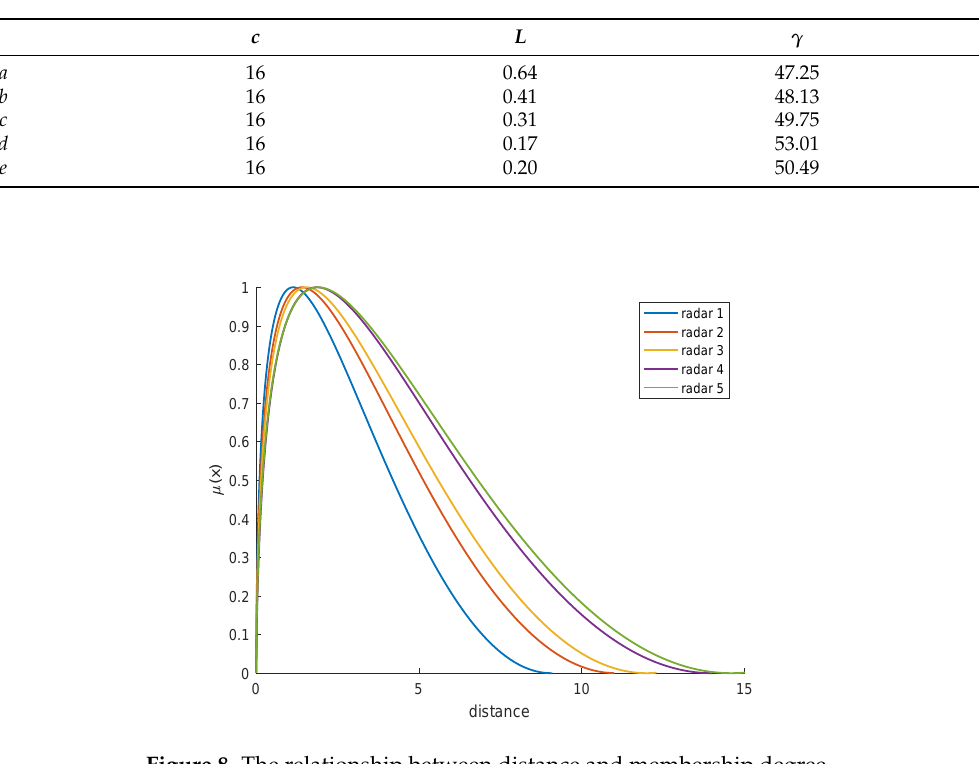
Table 2. The value of performance parameters.